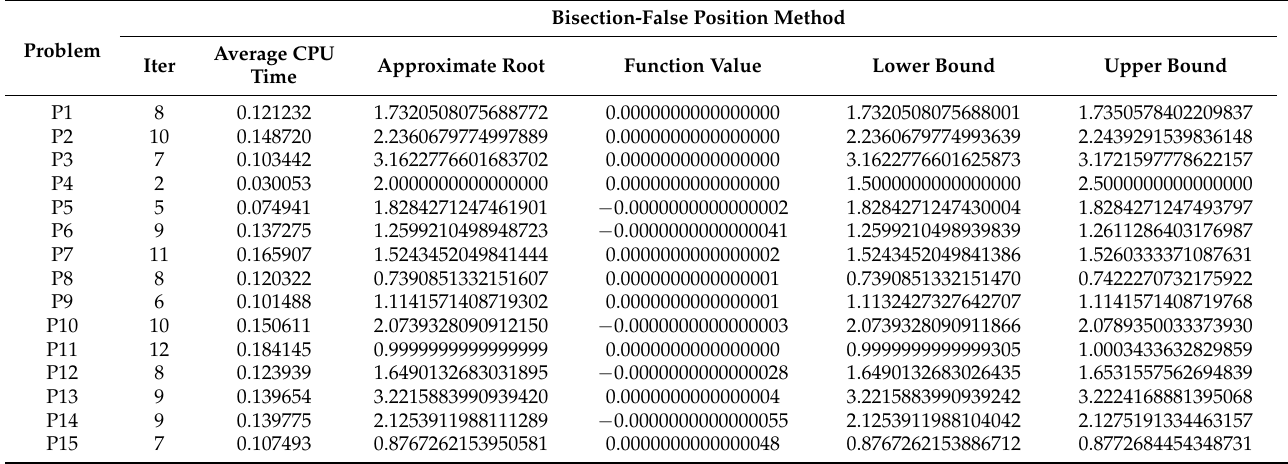
Table 8. Solutions of fifteen problems by the hybrid method bisection-false position.